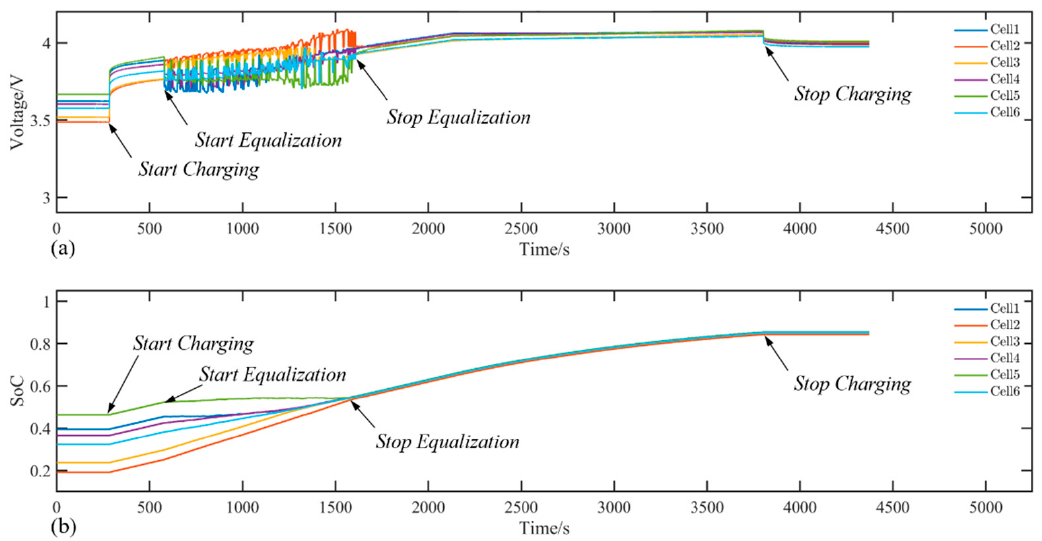
Figure 14. Equalization experiment based on VSSGPC strategy in CC-CV operating condition: ( a ) Voltage; ( b ) SoC.